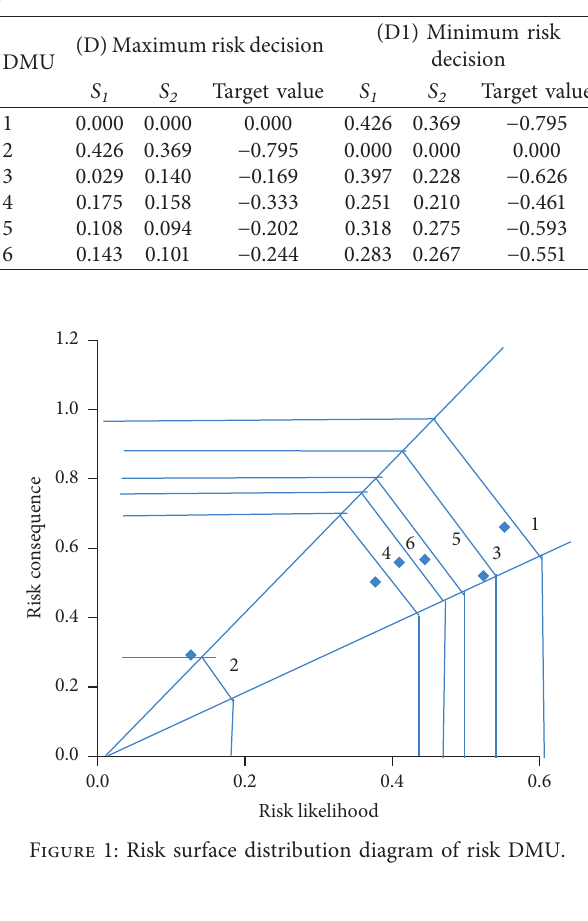
Table 4: Maximum and minimum risk decision values and ob- jective function.